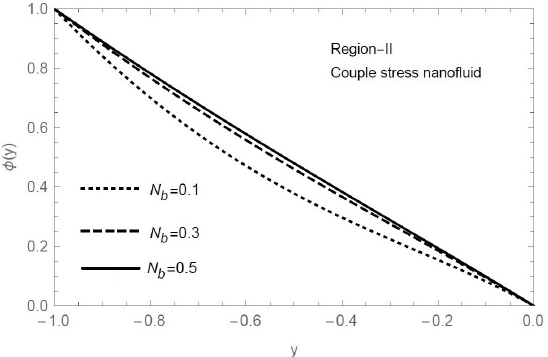
Figure 8: The influence of couple stress parameters ξ i on tempera- ture profiles using λ 1 = 50, h = 1, δ i = 0.1, Γ i = 0.1, N b = N t = 0.1, Pr i = 5 and µ = K = 0.5 .